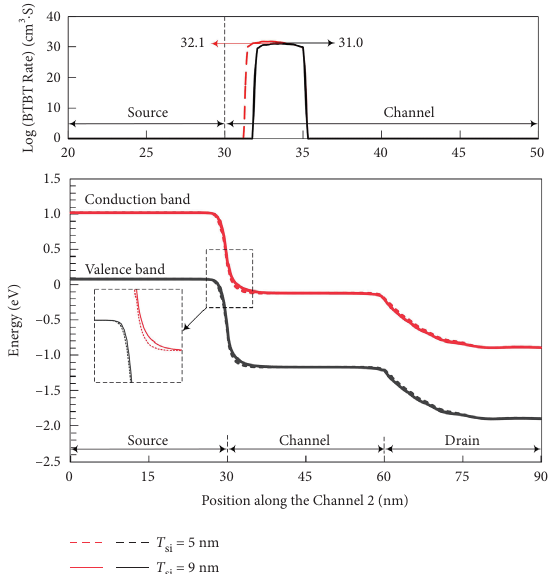
Figure 8: Energy band distribution at the top cut line with T